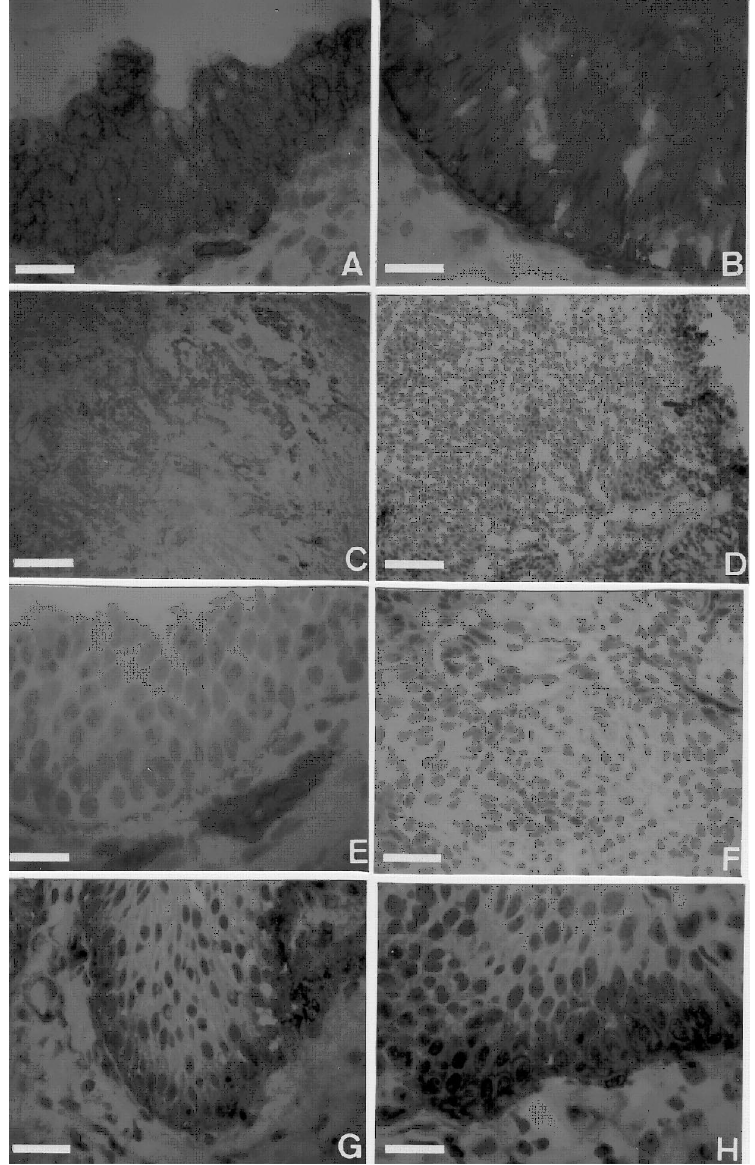
Fig. 1. Patterns of (cid:11) 2 (A–D) and (cid:12) 4 (E–H) integrins in normal urothelium and bladder cancer samples. A) Membrane (cid:11) 2 immunoreactivity at cell to cell junctions in all epithelial layers of normal urothelium. B) Superficial tumour with normal (cid:11) 2 expression on cell–cell boundaries. C) Invasive carcinoma with diffuse (cid:11) 2 pattern in cytoplasm of most ep- ithelial cells. D) Loss of (cid:11) 2 expression in superficial bladder cancer: all tumour cells were totally (cid:11) 2 chain negative. (Streptavidin-biotin-phosphatase complex method; A) and B) bars = 20 (cid:22) m, (cid:2) 500, C) bar = 80 (cid:22) m, (cid:2) 125 and D) bar = 50 (cid:22) m, (cid:2) 200.) E) Section of normal bladder tissue with intense and regular (cid:12) 4 expression at the junction of basal cells and the lamina propria. The underlying connective tissue is negative except endothelial cells which also express the (cid:12) 4 chain. F) Superficial carcinoma with normal (cid:12) 4 immunoreactivity as in normal urothelium. G) and H) Tumours with loss of polarisation of the (cid:12) 4 integrin: only the basal layer (G) or also in some cases suprabasal layers (H) were positively stained with AA3 antibody. (Indirect immunophosphatase method; E) and F) bars = 15.6 (cid:22) m, (cid:2) 640, G) bar = 20 (cid:22) m, (cid:2) 500 and H) bar = 12.5 (cid:22) m, (cid:2)